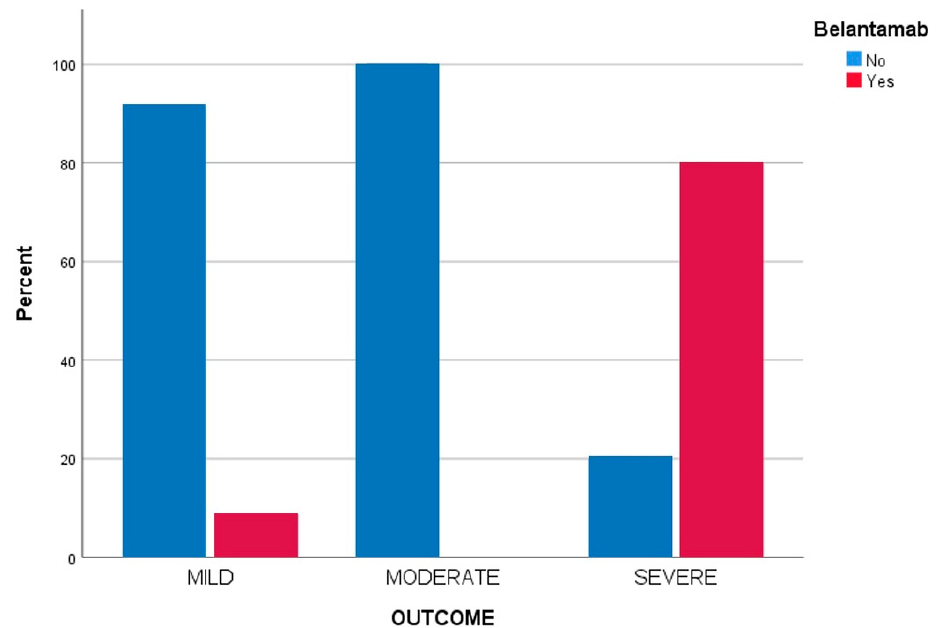
Figure 2. Bar chart of the differences in COVID-19 outcomes according to type of active treatment.